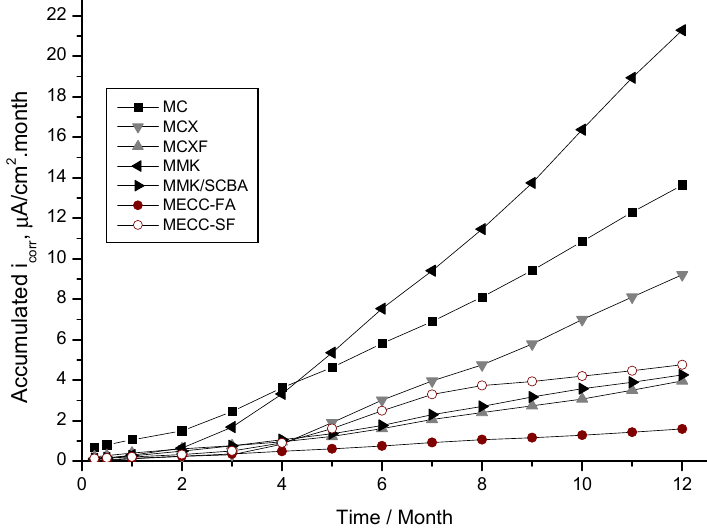
Figure 5. Evolution of the accumulated corrosion current density of AISI 1018 CS in mortars, exposed in 3.5 wt % NaCl solution.